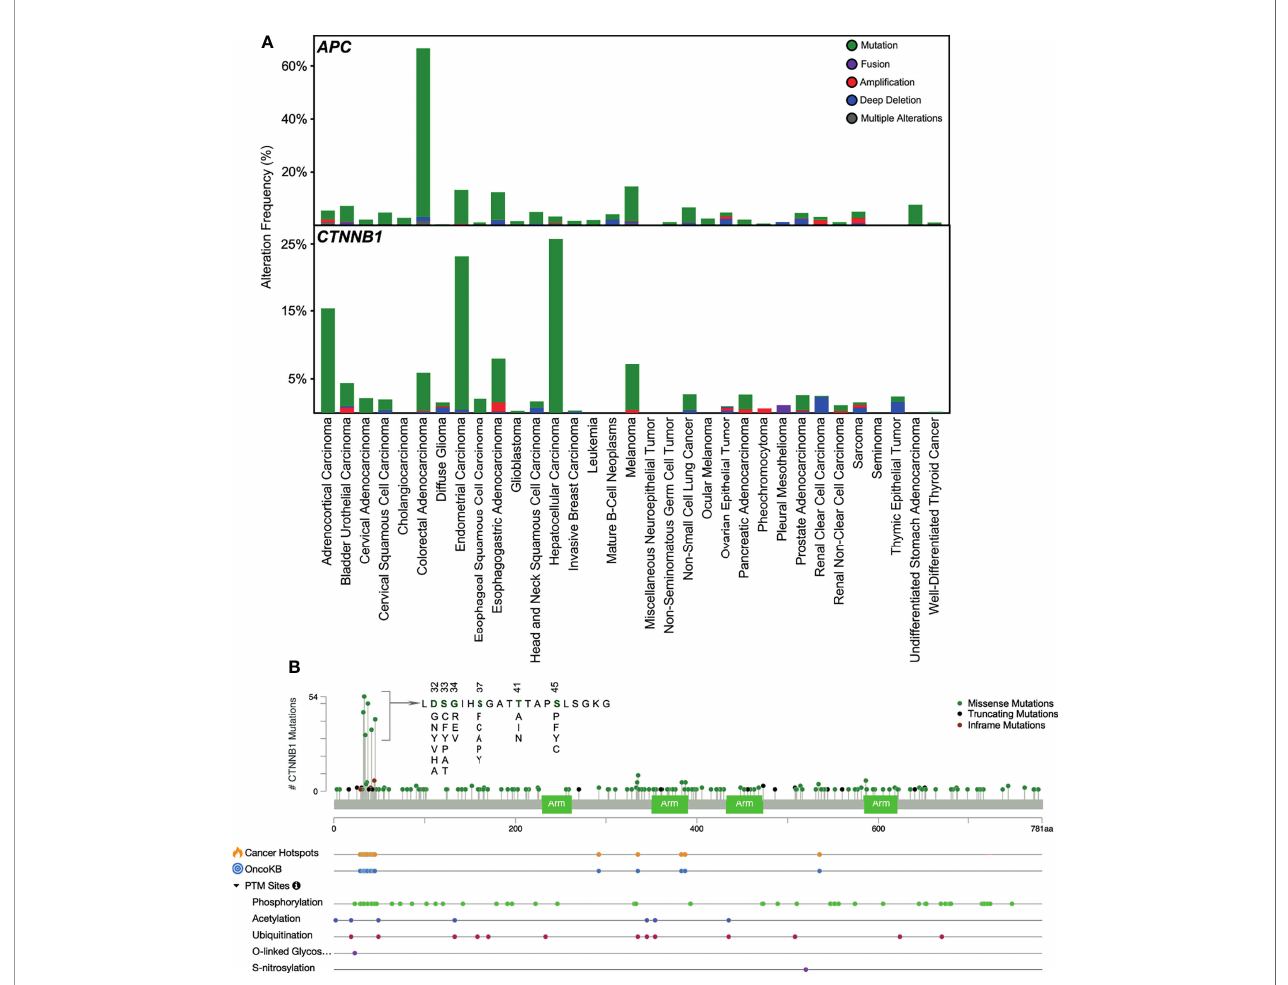
FIGURE 3 | Mutations in APC and b -catenin. (A) Mutations in APC and CTNNB1 ( b -catenin) in different cancers have been collected from cbioportal. (B) Mutation frequency in CTNNB1 gene and other post-translational modi fi cations collected from cbioportal. TCGA PanCancer Atlas Studies